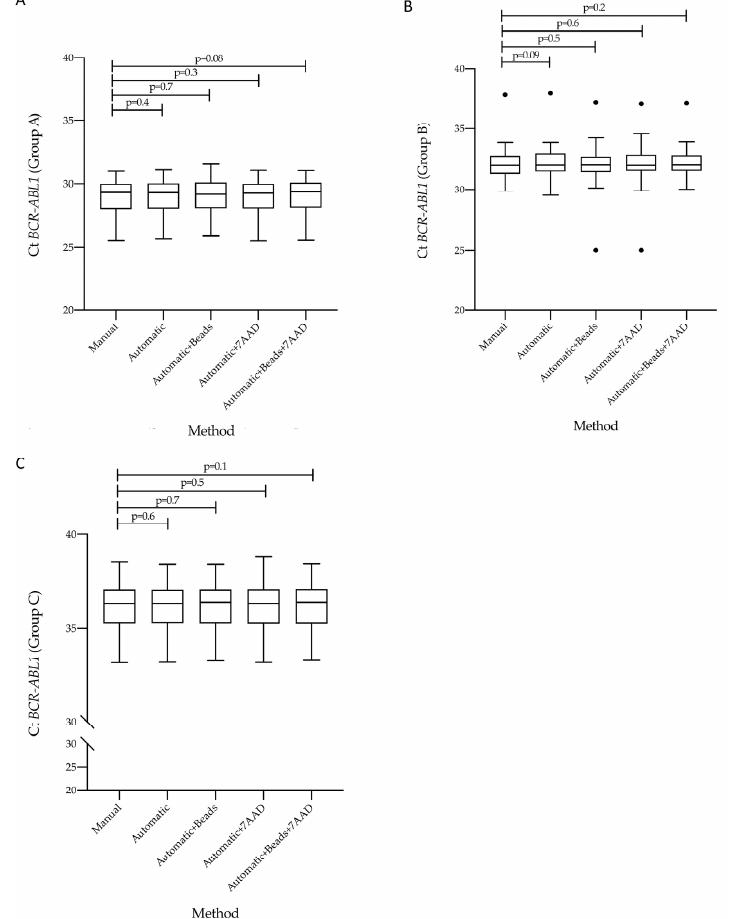
Figure 3. Measurement of BCR-ABL1 Cycle threshold value on matched samples counted by five different enumeration assays. Comparison of the Cycle Threshold (Ct) values of BCR-ABL1 gene transcript measured by Q-PCR in matched samples counted by five different protocols. BCR-ABL1 gene transcript was assessed in patients stratified into three groups, each consisting of 30 individuals, according to their BCR-ABL1/ABL1 IS transcript: Group A (10% > BCR-ABL1/AB1L IS > 1%) ( A ), Group B (1% > BCR-ABL1/ABL1 IS > 0.1%) ( B ), and Group C (0.1% > BCR-AB1L/ABL1 IS > 0.01%) ( C ). The BCR-ABL1 Ct values were determined for each method and showed as Tukey-boxplots. Thick lines in each boxplot represent the median BCR-ABL1 Ct value for each counting method. The dark dots indicate the outlier’s values. The student-paired t -test was used to test the difference between the five counting methods and p value below 0.05 was considered statistically significant.